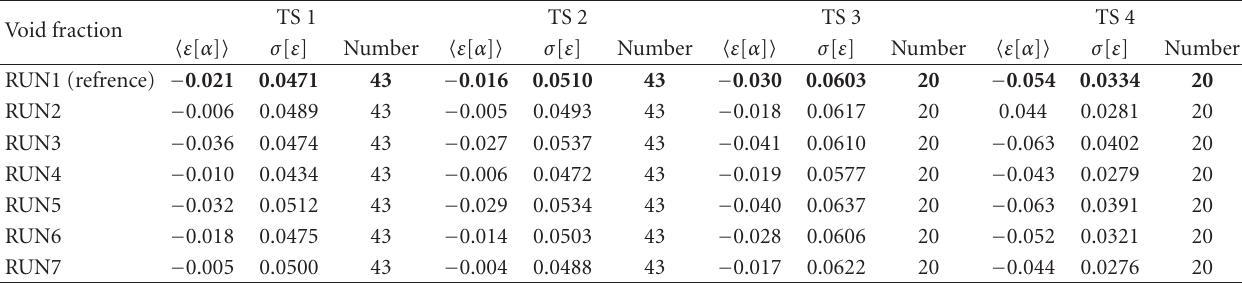
Table 4: PSBT subchannel tests, CATHARE2: summary of sensitivity analysis